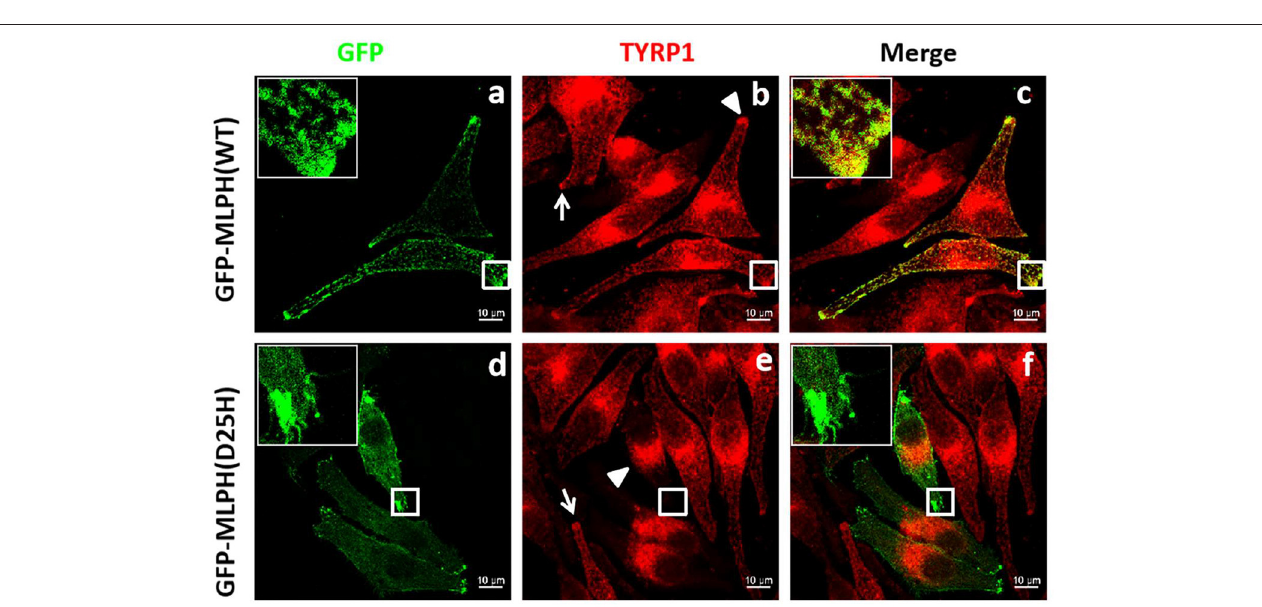
FIGURE 5 | Distribution of TYRP1 in melanocytes transfected with GFP-MLPH (WT) or GFP-MLPH (D25H). (a–f) MNT1 cells were transfected with GFP-MLPH (WT) or GFP-MLPH (D25H). Transfection with GFP-MLPH (WT) showed a peripheral distribution of TYRP1 [ (b) , arrowhead], while transfection with GFP-MLPH (D25H) showed the typical clustering of TYRP1 in the perinuclear region [ (e) , arrowhead] and lack of the TYRP1 in the cell periphery [ (e) , rectangle]. GFP-MLPH (WT) colocalized with TYRP1 (c) in the cell periphery while GFP-MLPH (D25H) did not (f) . Bars: 10 µ m.